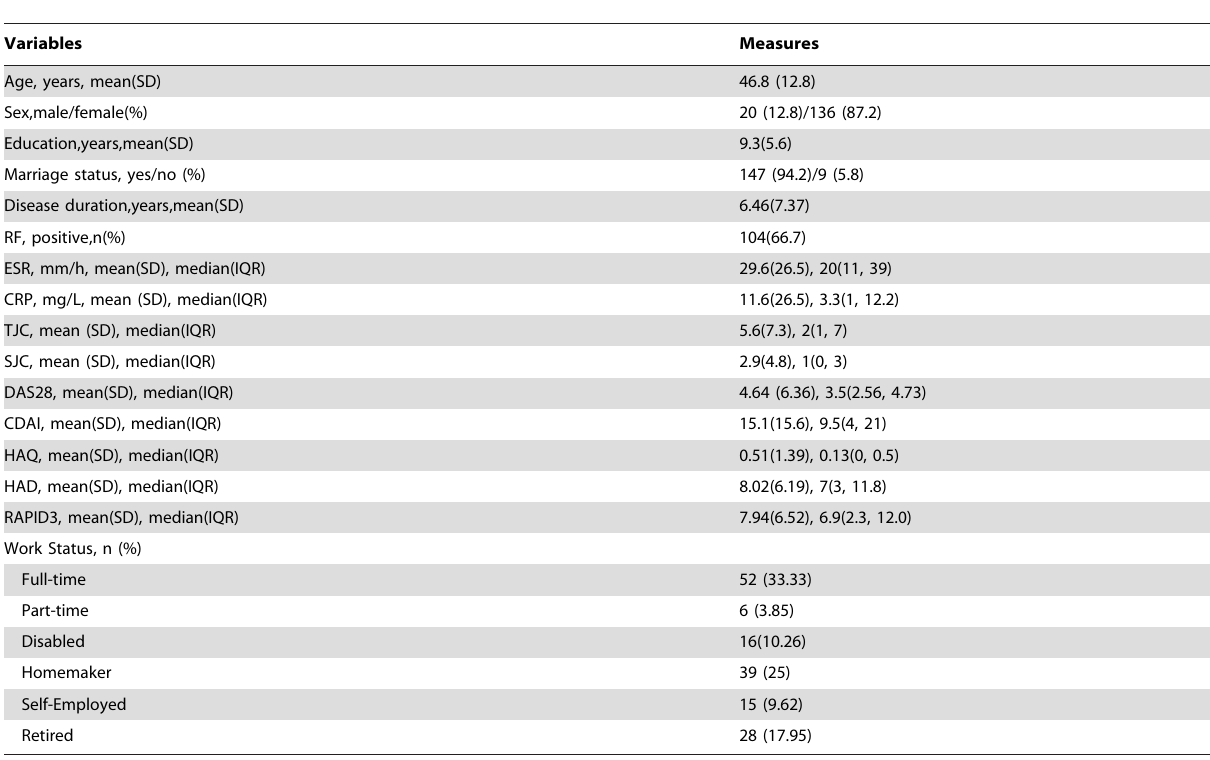
Table 1. Demographic and clinical characteristics of the RA patients.